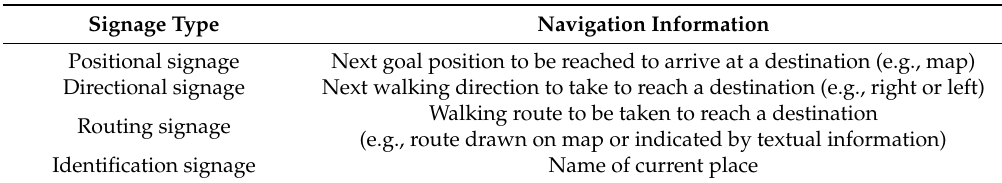
Table 1. Signage type and navigation